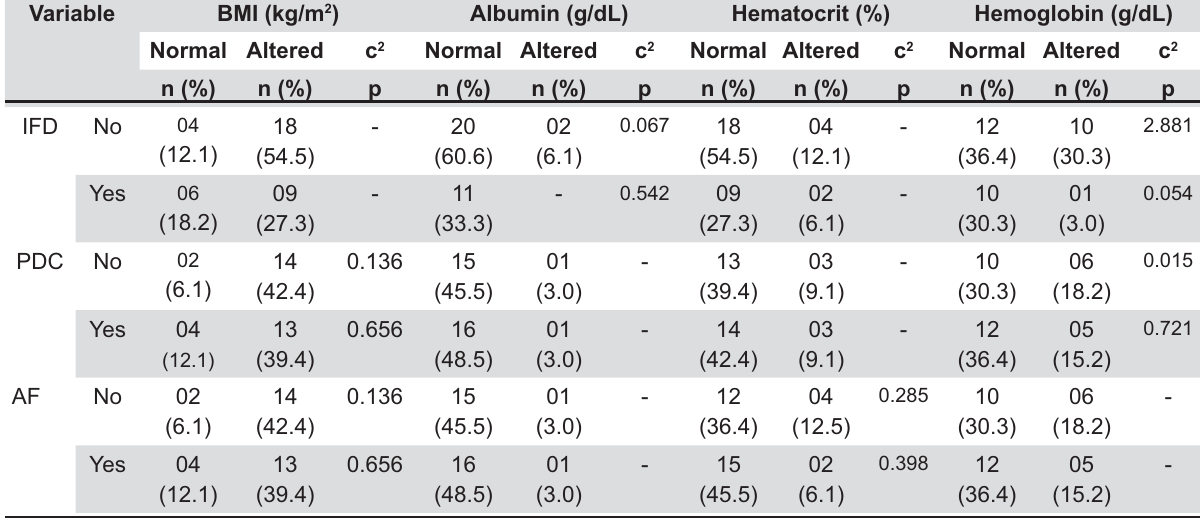
Table 4- (cid:14)^(cid:17)(cid:17)](cid:10)(cid:16)(cid:11)(cid:22)(cid:16)](cid:18)(cid:14)_(cid:9)(cid:22)?(cid:9)(cid:9)(cid:18)(cid:14)‘](cid:8)(cid:12)(cid:14)(cid:4)(cid:11)(cid:17)(cid:17)(cid:14)j(cid:18)(cid:8)(cid:9)+(cid:14)&‘(cid:4)j(cid:27)(cid:13)(cid:14)(cid:11)(cid:21)_X(cid:15)(cid:16)(cid:18)(cid:13)(cid:14)(cid:23)(cid:9)(cid:15)(cid:11)(cid:22)](cid:10)’(cid:16)(cid:22)(cid:13)(cid:14)(cid:23)(cid:9)(cid:15)](cid:19)(cid:21)]_(cid:16)(cid:18)(cid:14)(cid:11)(cid:18)(cid:8)(cid:14)(cid:16)(cid:21)(cid:21)(cid:25)(cid:20)(cid:22)(cid:22)(cid:16)(cid:18)(cid:19)(cid:14)(cid:8)(cid:9)(cid:18)(cid:22)X’(cid:9)(cid:17)(cid:14)&j(cid:5)(cid:3)(cid:27)(cid:14)&(cid:18)]{